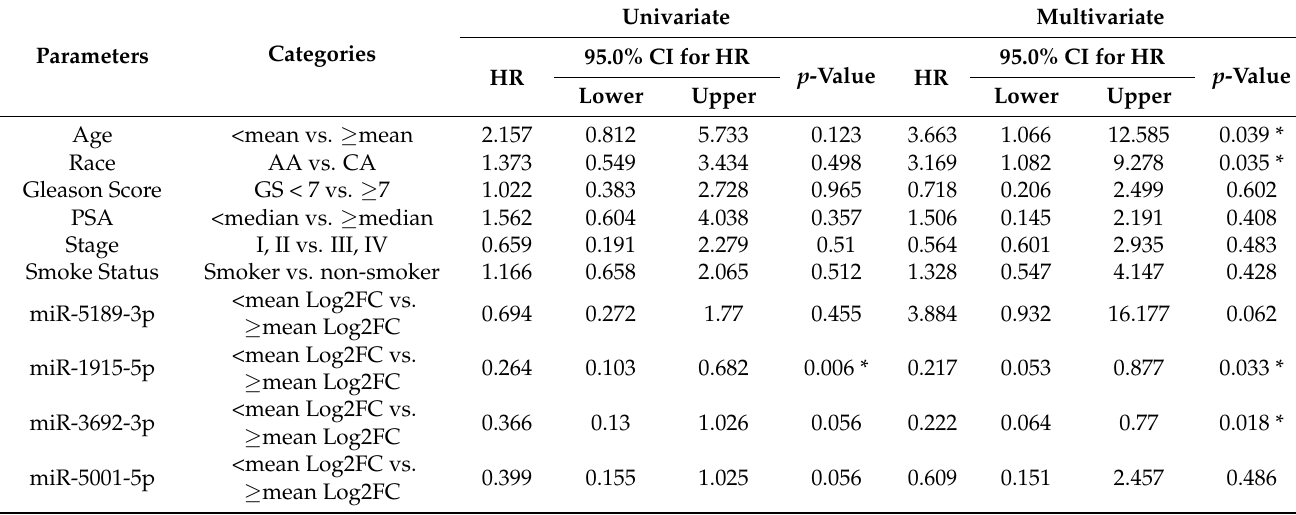
Table 5. Univariate and multivariate Cox regression analysis assessing the association of the sEV-associated miRs as well as